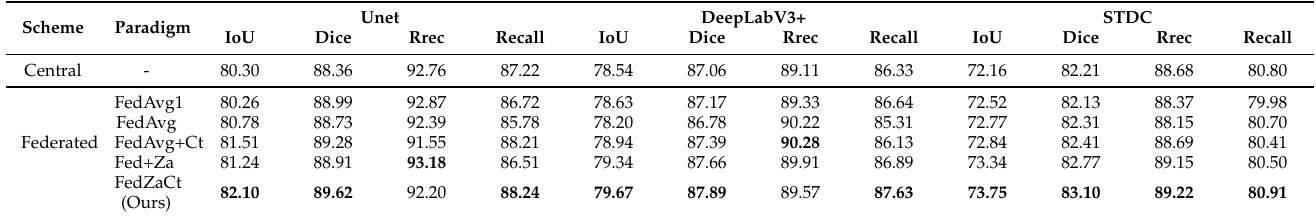
Table 1. Mean evaluation values of ten repeated experiments on the private aortic